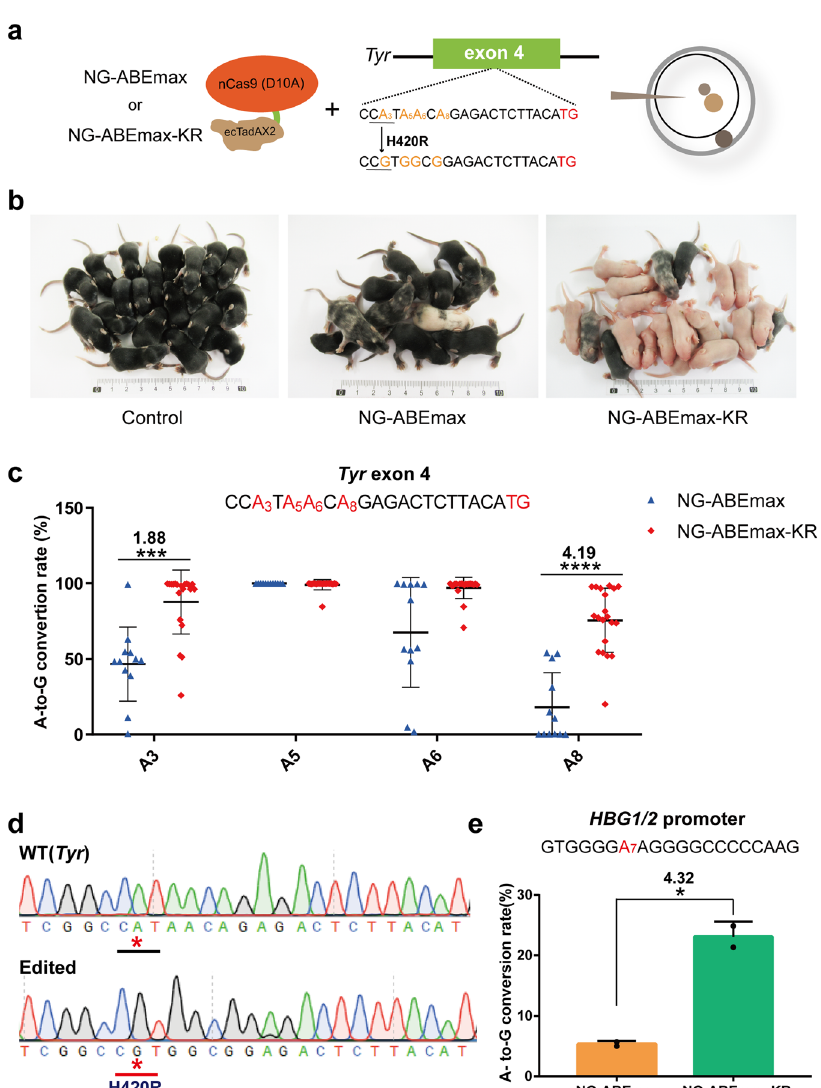
Fig. 4 Application of NG-ABEmax-KR for the generation of mice disease models and human gene therapy. a Schematic of editing activity comparison of NG-ABEmax and NG-ABEmax-KR in mouse embryos via zygote intracytoplasmic injection. b The newborn pups (days 10) produced by intracytoplasmic injection of NG-ABEmax or NG-ABEmax-KR mRNA and Tyr sgRNA. The Tyr mutant mice (H420R) are in white and the wild-type are in black, respectively. Control represents only ddH 2 O injection. c Statistical analysis of on-target A-to-G base conversions induced by NG-ABEmax ( n = 12), NG-ABEmaxKR ( n = 20) in all pups. Data are mean ± s.d for the indicated numbers of mice. Each A base was highlighted in red. *** P < 0.001, **** P < 0.0001 by Student ’ s unpaired two-sided t test. Exact P value of A3 = 0.00023, exact P value of A8 = 0.00001. d Sanger sequencing chromatograms con fi rmed the editing events. The desired mutation was highlighted with red star. e Boosted editing ef fi ciency (A7) of NG-ABEmax-KR at HBG1/2 . Error bars indicate mean ± s.d. ( n = 2 independent experiments). * P < 0.001 by Student ’ s unpaired two-sided t test. Exact P value = 0.010120. Source data are available in the Source data fi